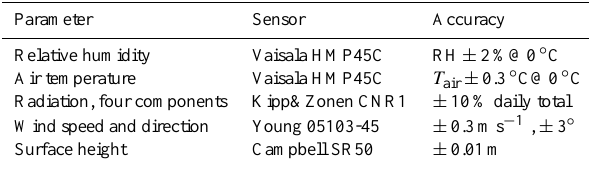
Table 1. Instruments of the